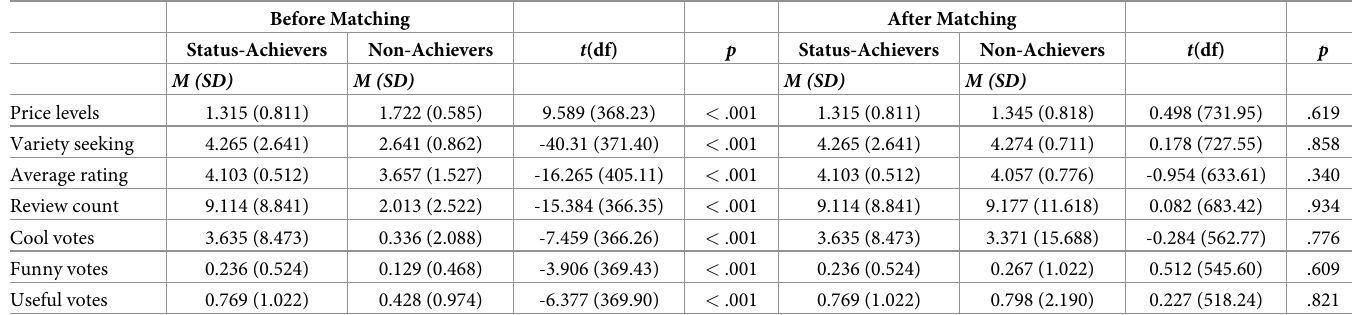
Table 1. Results of t Test on the variables that could capture users’ qualifications for elite status before and after propensity score matching. Before Matching